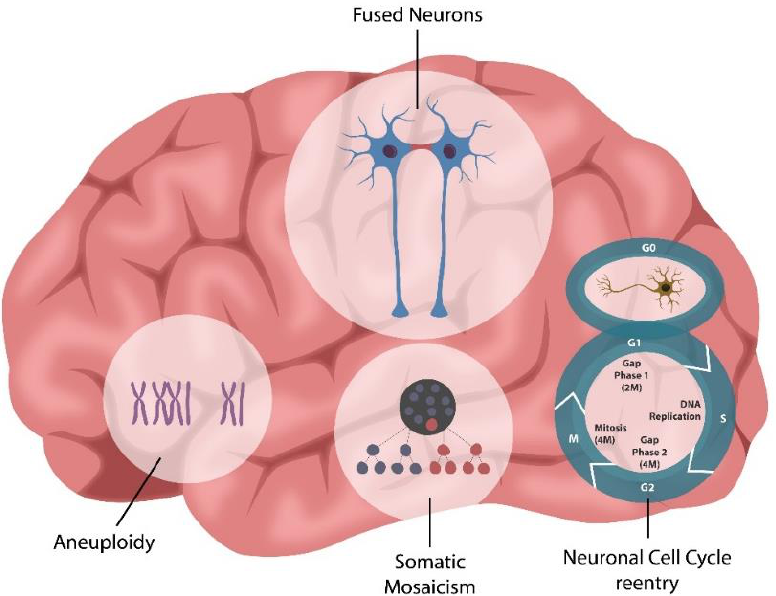
Figure 3. Neuronal cell–cell fusion occurs physiologically, in normal aging, or pathologically, in various conditions, including viral infections, Alzheimer’s disease (AD), multiple sclerosis (MS), radiation exposure, or chemotherapy [76] Neuronal syncytia formation likely accounts for previously unexplained phenomena, such as aneuploidy, somatic mosaicism, and neuronal cell cycle reactivation, documented in various neuropsychiatric